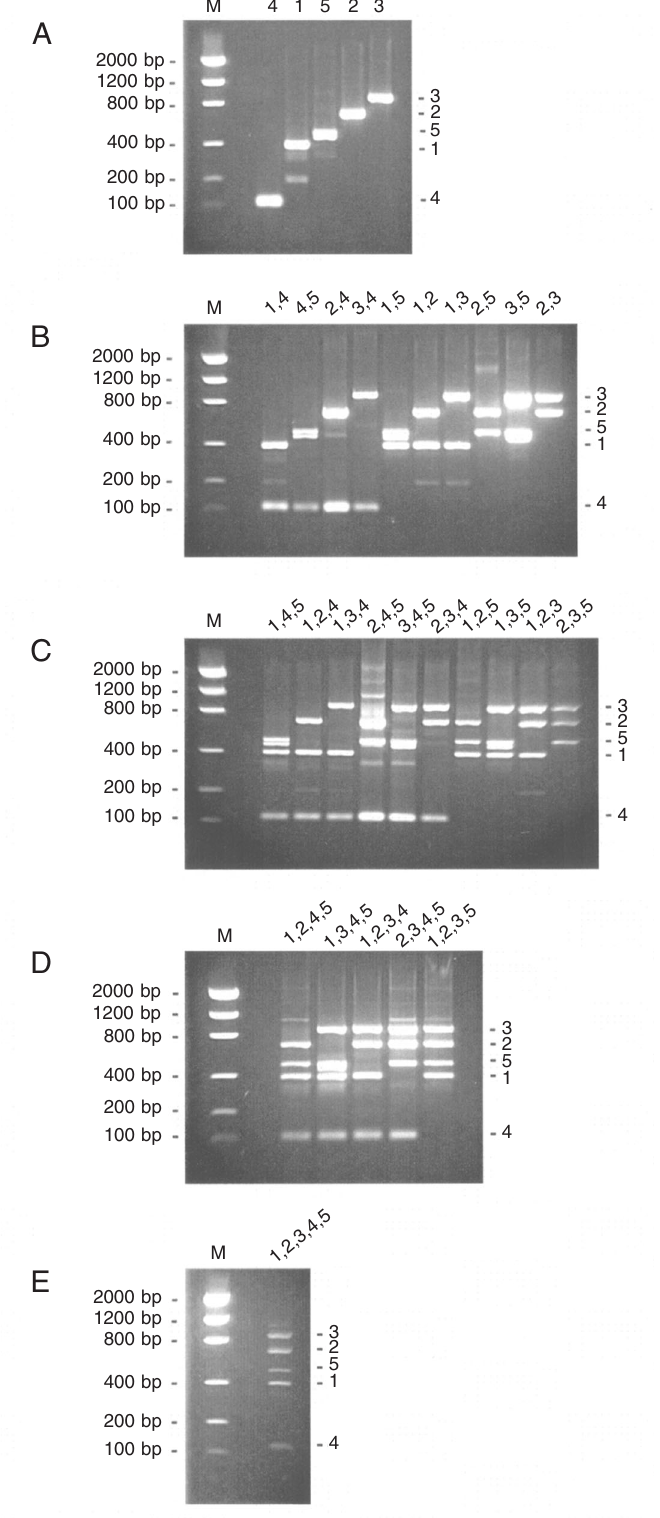
Figure 3. Agarose gel (2%) electrophoresis of multiplex PCR products. Each PCR assay was performed with five different plasmids (phylogenetic groups 1-5) to- gether with one sense and one (A), two (B), three (C), four (D), or five (E) antisense oligonucleotide primers. M: Molecular weight markers. Numbers at the top of each gel indicate the Torque teno virus groups from which the pair(s) of primers added to the corresponding assays were